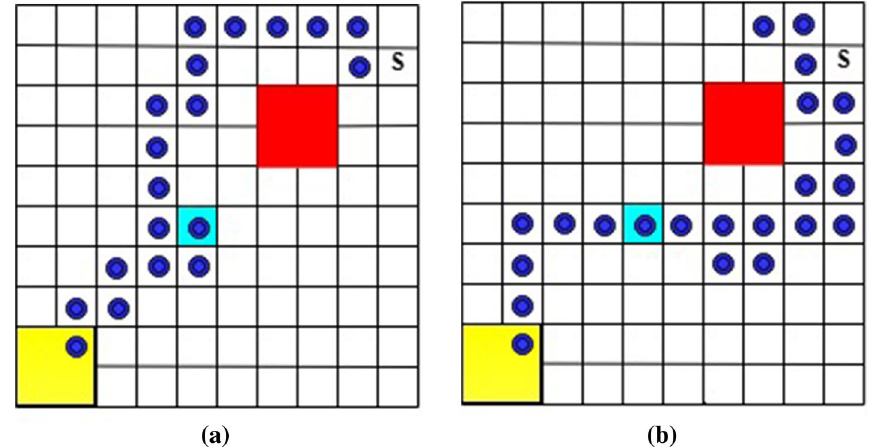
Figure 13. The generated trajectories from the optimal policy learned via QSQ-learning.